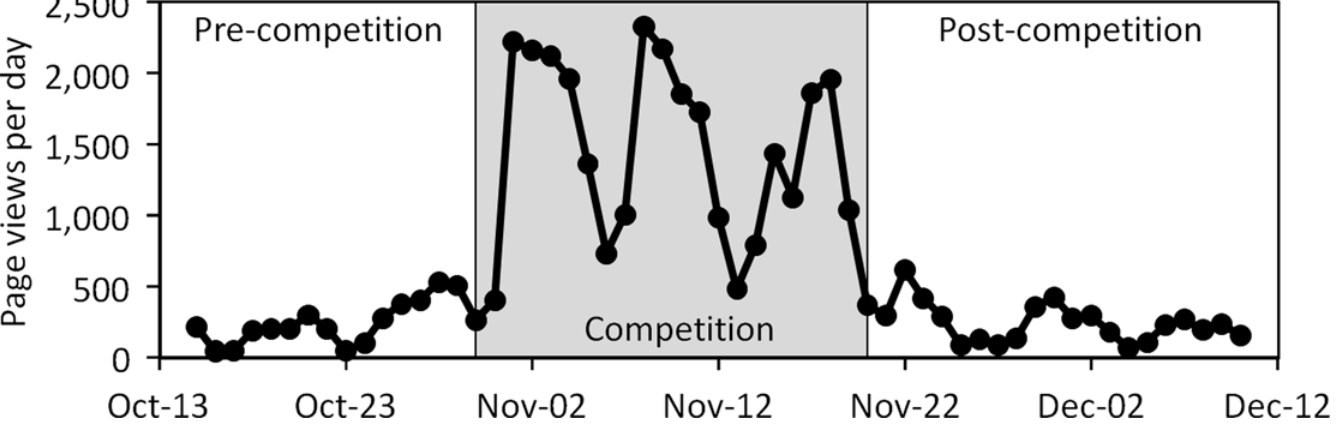
Fig 4. Web traffic to all building dashboards and Campus Conservation National website prior to, during and after the 2010 competition.